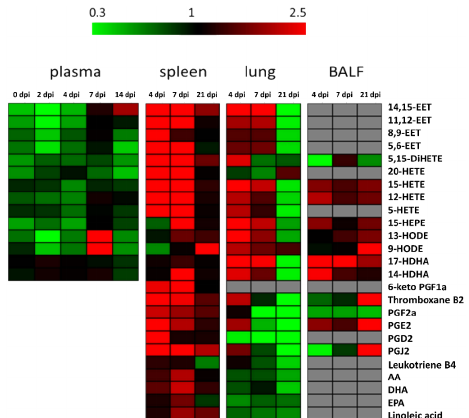
Figure 1. Heatmap displaying fold changes (infection / control) of all measured eicosanoid amounts of all sample types and time points. Decreased levels are shown in green, increased amounts in red and comparable amounts in black. Grey fields: below detection limit.